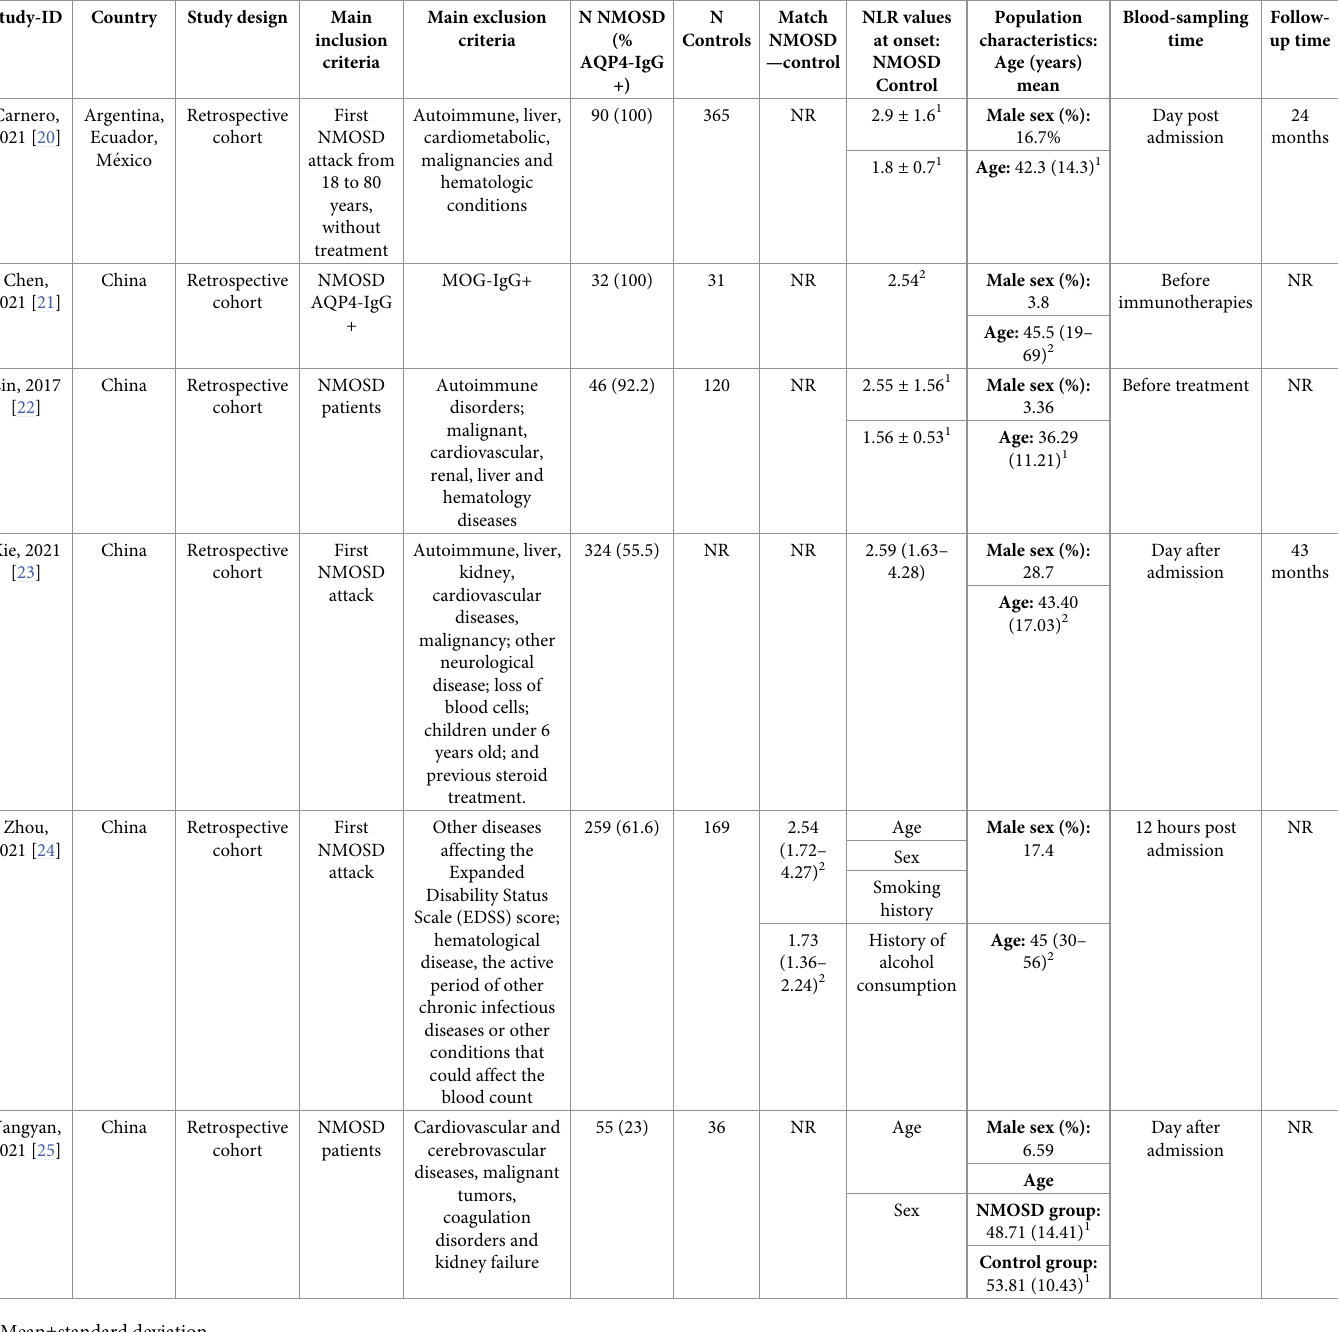
Table 1. Characteristics of the included studies evaluating the clinical and imagenologic significance of the neutrophil-to-lymphocyte ratio (NLR) in neuromyelitis optica spectrum disorder (NMOSD) (n = 6). Study-ID Country Population